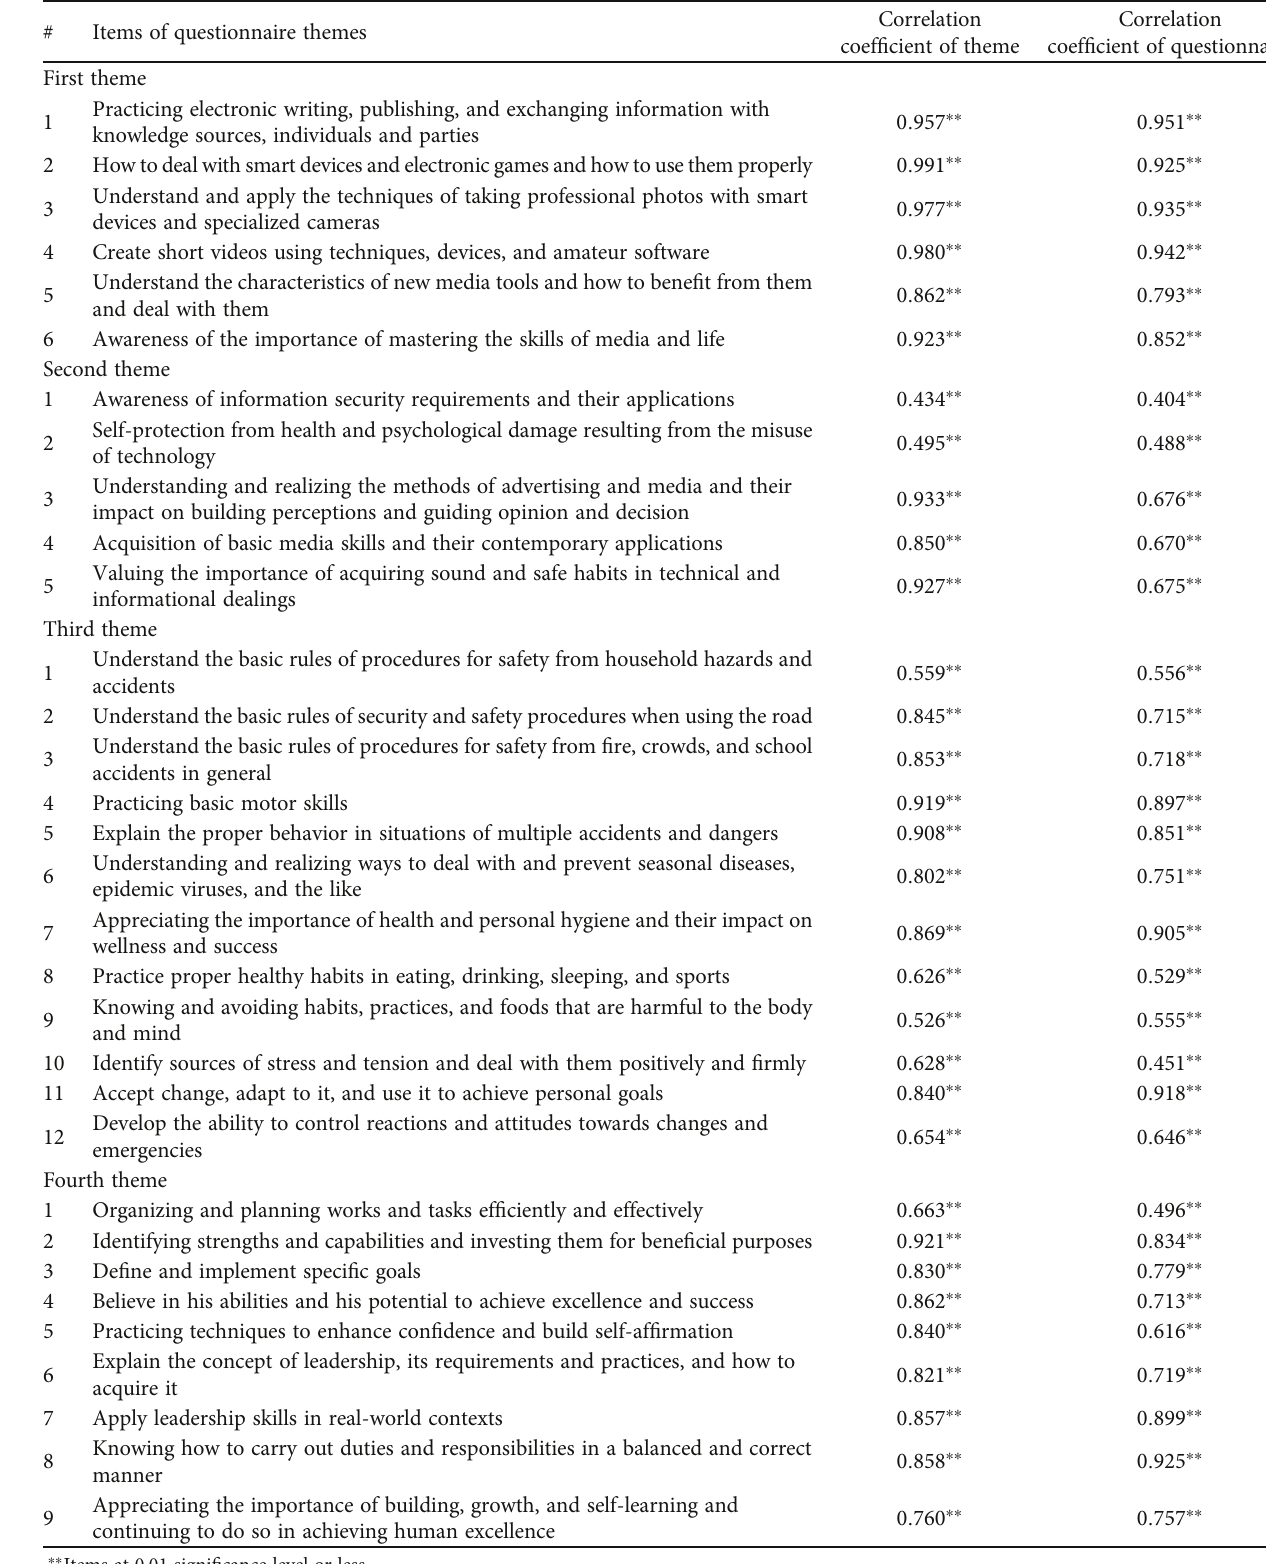
T ABLE 2: Correlation coef fi cients of the items of the study ’ s theme with the theme to which it belongs as well as with the total score of the